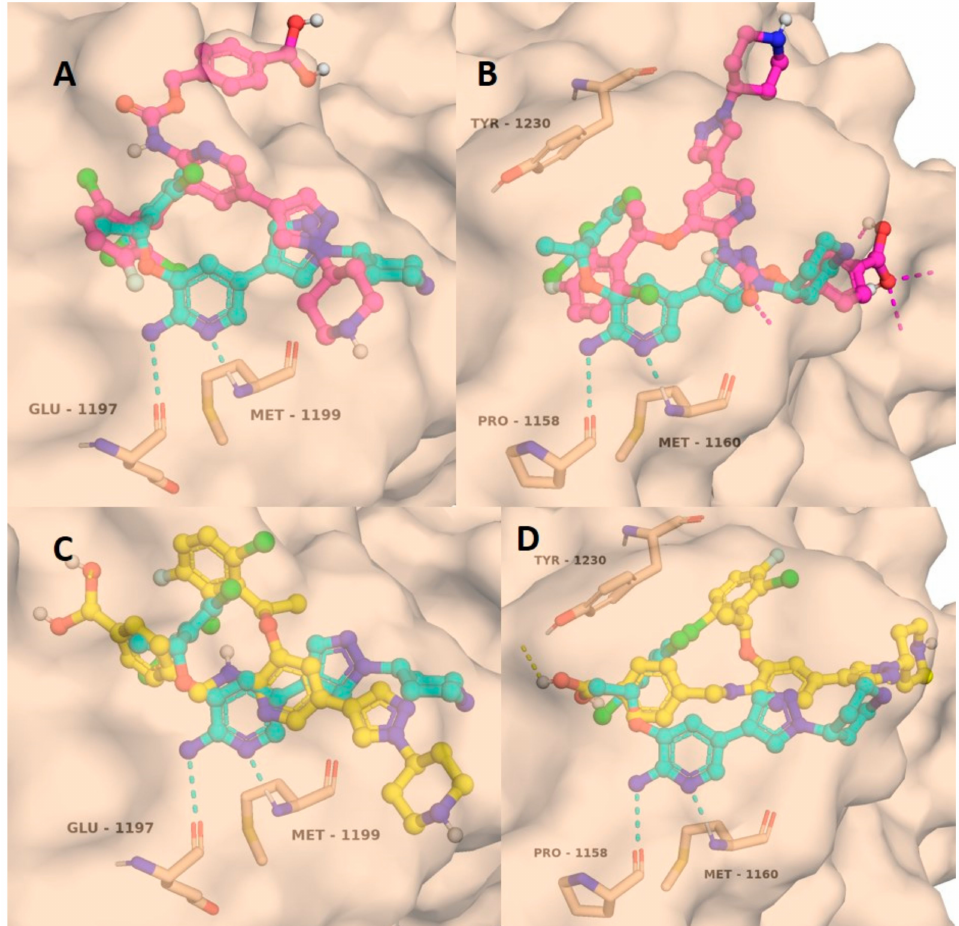
Figure 1. Best docking binding modes of prodrug A with ALK ( A , RCSB protein data bank (PDB) ID: 2XP2) and c-MET ( B , PDB ID: 2WGJ) as well as prodrug B with ALK ( C ) and c-MET ( D ) compared